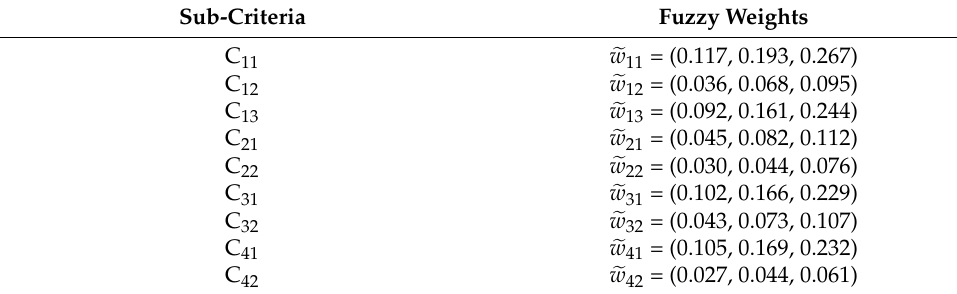
Table 9. Fuzzy weights of sub-criteria with respect to the overall goal. Sub-Criteria